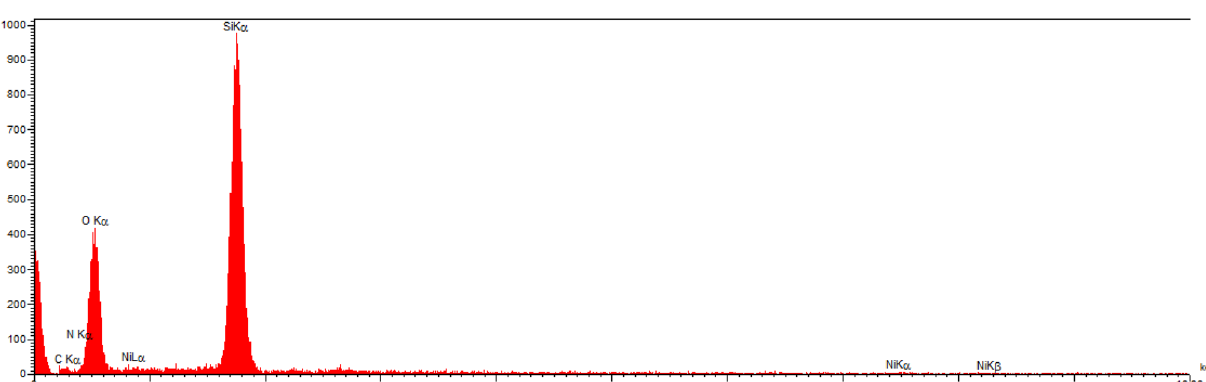
Figure 7. TEM images of HMS/Pr-Xa-Ni ( a,b ), particle size distribution histogram of HMS/Pr-Xa-Ni ( c ).